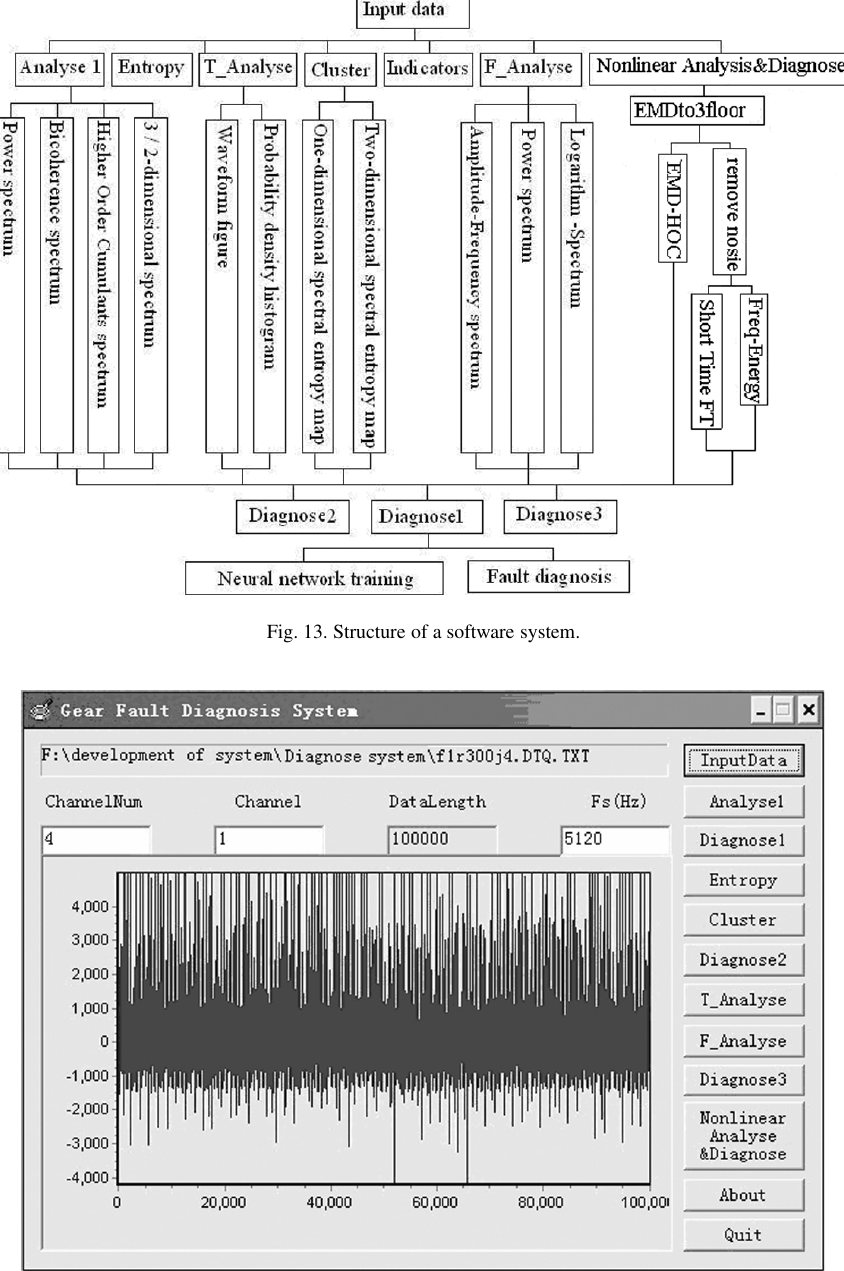
Fig. 14. The main interface of software and the display of interface after importing